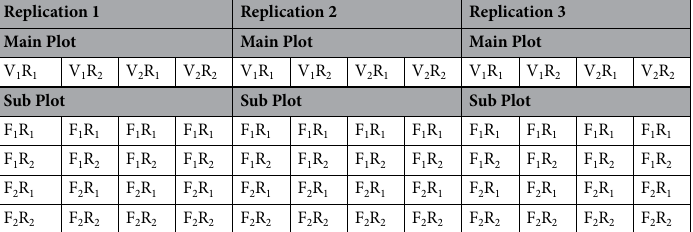
Replication 1 Replication 2 Replication 3 Main